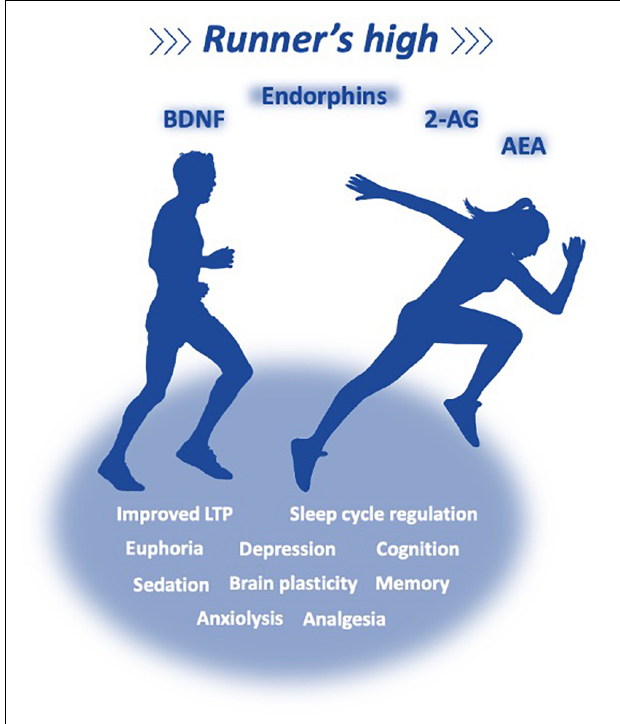
FIGURE 4 | Exercise reverts some of the collateral effects of a sedentary lifestyle, and has the potential to improve metabolic, cardiovascular, and immune parameters, providing a better memory, cognition, and sleep cycle regulation, delaying brain aging and chronic and neurodegenerative pathologies. It is a common belief that most of the reward induced by acute or chronic exercises (reward, nociception, mood behavior, anxiety, and performance) are related to the release of endorphins and eCBs, which interact with multiple opioid (mu, kappa, and delta) and cannabinoid receptors; Irrefutable evidence demonstrate that the ECS is a major player in systemic energy metabolism, inflammation, appetite control, and pleasure (acute anxiolysis, analgesia, antidepressant effects, sedation, and euphoria) of the so-called runner’s